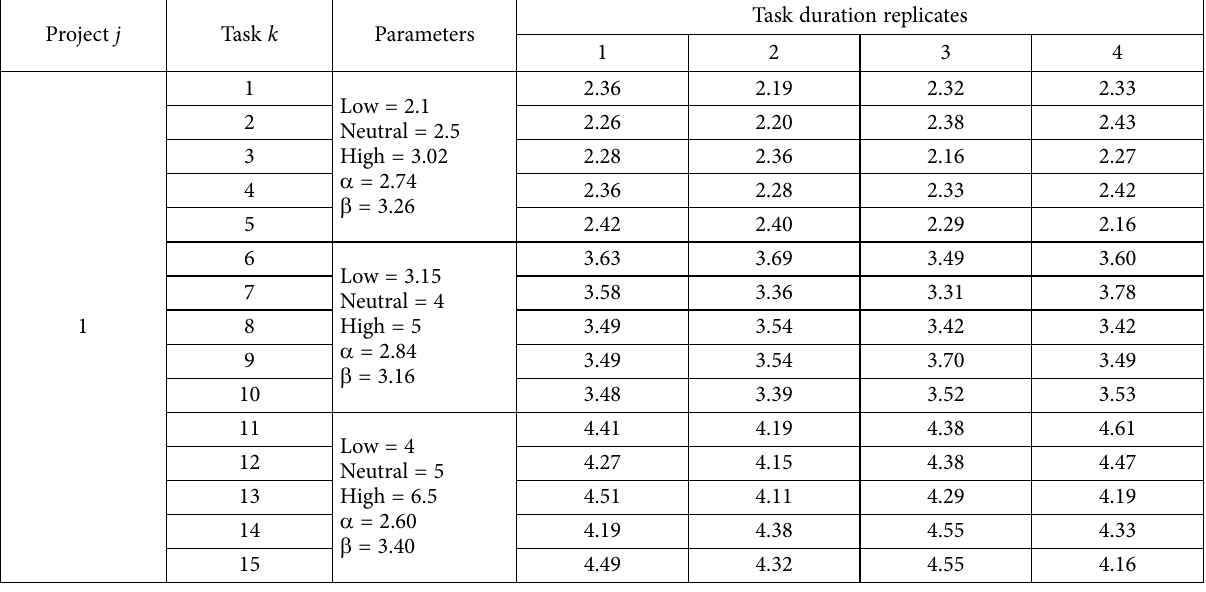
Table 16. The comparison of objective function values between normal and PERT distributed block durations Model output